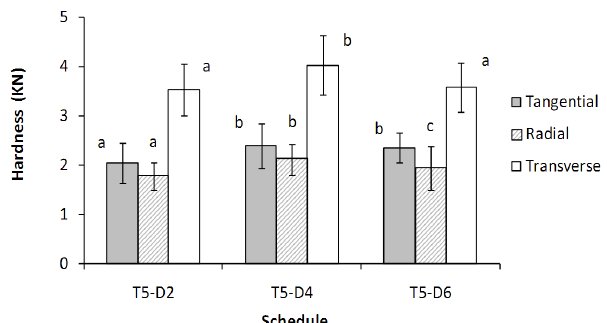
Fig. 3. Hardness in tangential, radial, and transverse surfaces of samples dried under the three adopted kiln schedules